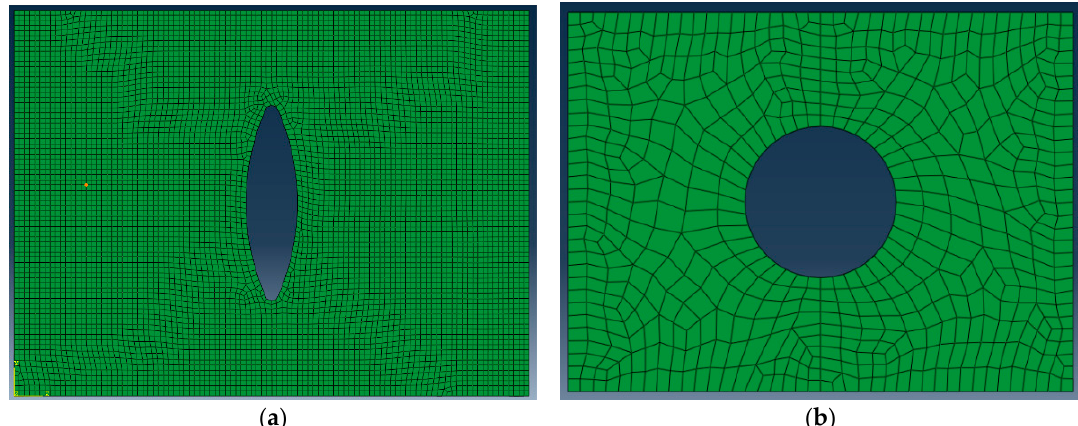
Figure 10. ( a ) The 38 × 10 delamination shape inserted between the 4th and 5th plies of specimen 1, with a 0.1 mm additional layer. ( b ) The 31 × 36 delamination shape inserted between the 12th and 13th plies of specimen 2, with a 0.1 mm additional layer.